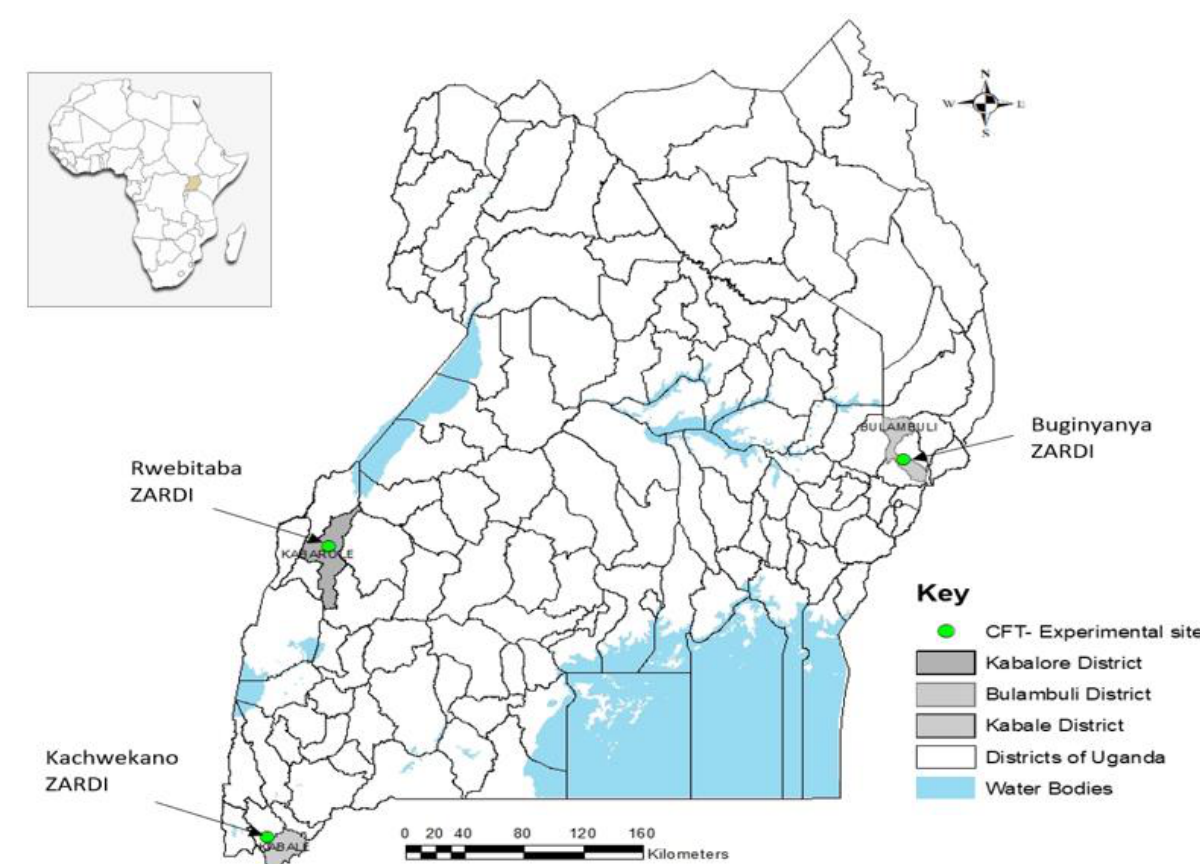
Figure 1. Location of the three experimental sites in Uganda, representing the main agroecologies for potato production, where confined field trials were undertaken.